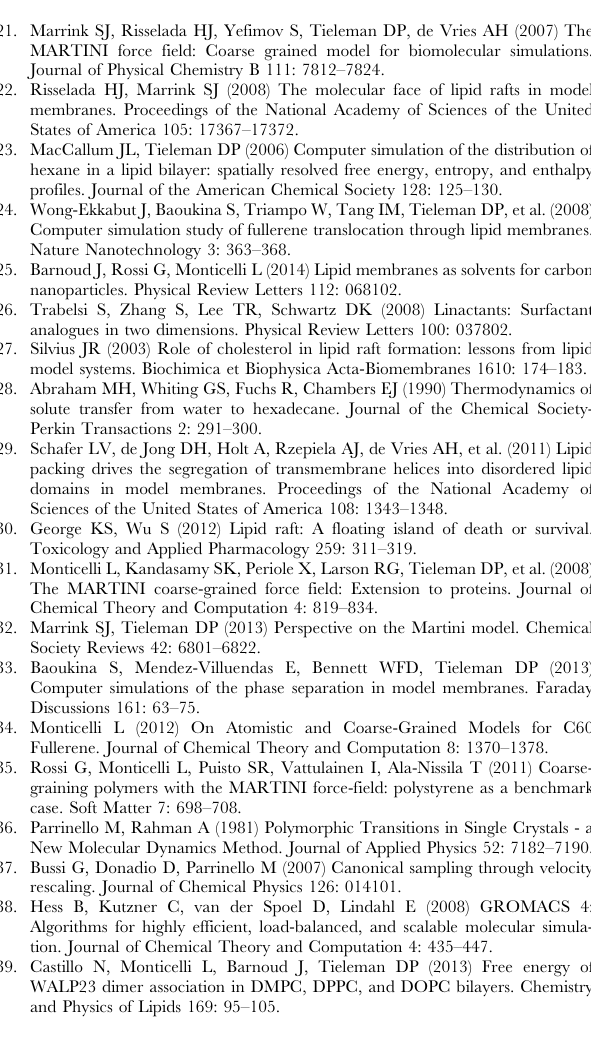
absence of solute. (TIFF) Figure S2 Mechanism of action of aromatic com- pounds. (a) Solute distribution (expressed as solute-DLiPC contact fraction) for aromatic compounds at different concentra- tions and temperatures. ‘‘L’’ stands for low concentration and ‘‘H’’ stands for high concentration. All aromatic compounds show a strong preference for unsaturated lipids. (b) Cholesterol distribu- tion (expressed as cholesterol-DLiPC contact fraction) at 295 K. The vertical solid line indicates the value observed in the absence of solute; the dashed lines represent error estimates. (TIFF) Figure S3 Difference in thickness between L o and L d phases. Left panels: histograms of membrane thickness in the absence and in the presence of different solutes. Thicknesses are calculated separately for the DLiPC and the DPPC components, based on the distance (along the bilayer normal) between phosphate groups in each leaflet. Line colors are the same as in